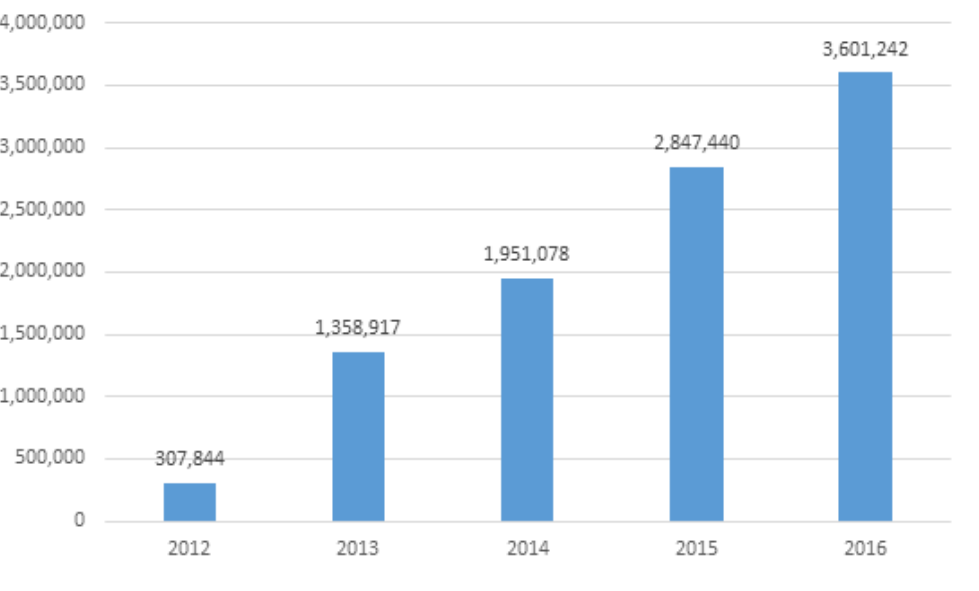
Figure 4. Sessions of NTU OCW users on the website each year.